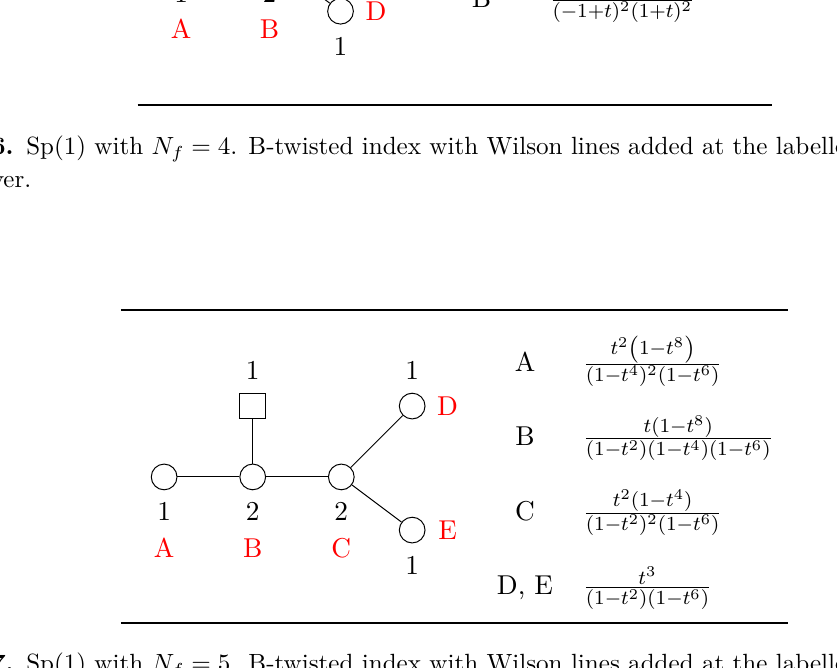
Table 7. Sp(1) with N f = 5 . B-twisted index with Wilson lines added at the labelled position in the quiver. This is also the E family for k = 1 . 5